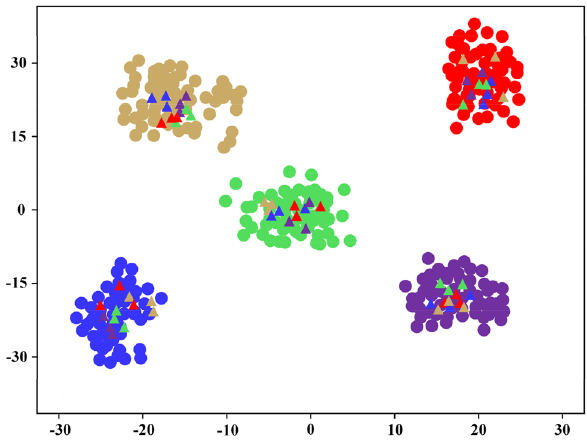
Fig. 3 A t-SNE figure to visualize i-vectors of source utterances and adversarial examples. Source voices are denoted by circles with five different colors with each color for one speaker. Adversarial examples are denoted by triangles with five different colors where the color indi- cates the source speaker of an adversarial example (Better viewed in color)